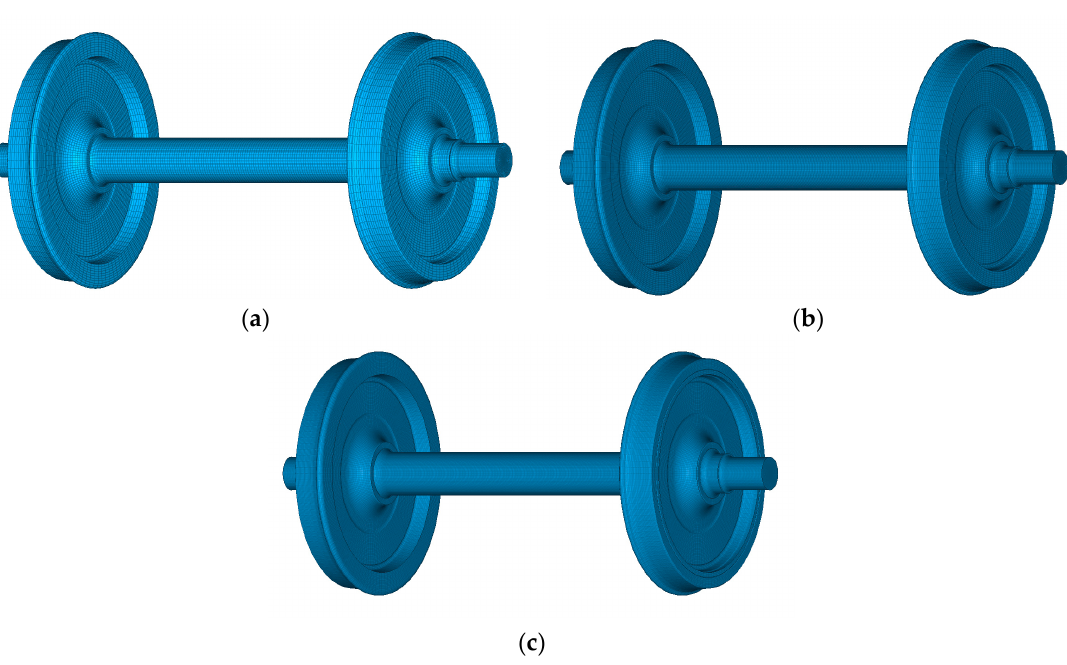
Figure A1. The finite element model: ( a ) Model 1 (the model in the manuscript, element count: 255,360, node count: 267,771); ( b ) Model 2 (element count: 556,800, node count: 573,673); ( c ) Model 3 (element count: 834,860, node count: 856,285).